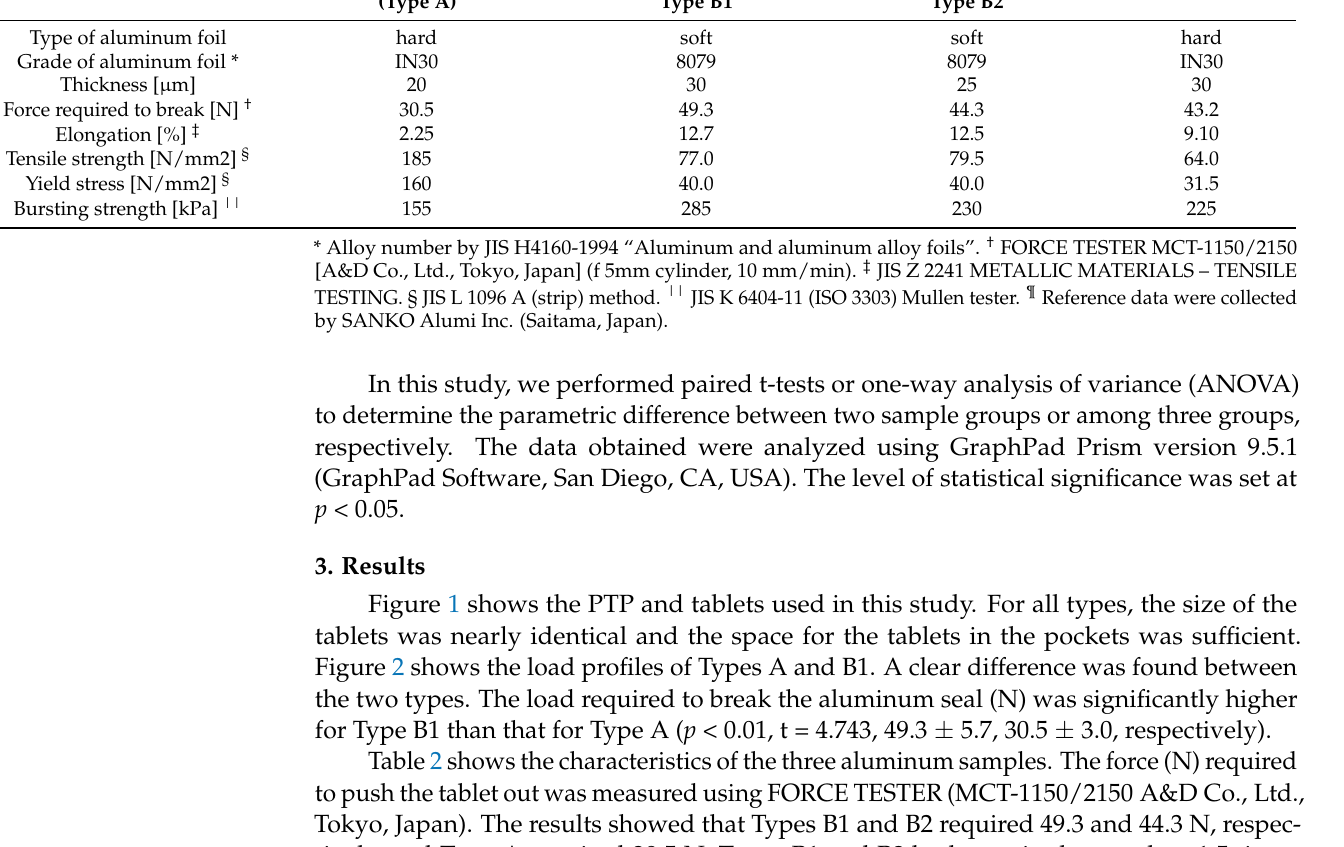
Figure 3. Ease of opening of sample Type B1. The score is the subjective evaluation after the CR adult test in the group of older adults. Table 2. Performance of the aluminum Table 1. EN 14,375 child and adult test (for non-reclosable packaging).